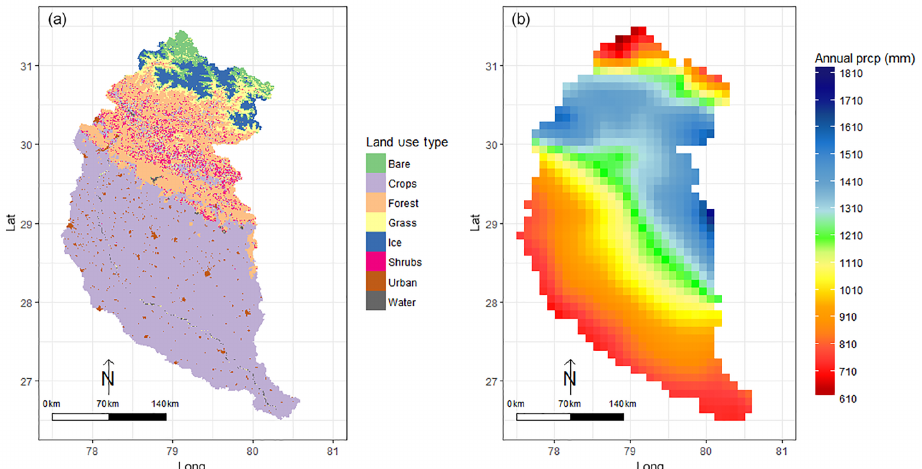
Figure 2. (a) Land-cover map of the Upper Ganges basin, for the year 2010, as developed by Tsarouchi et al. (2014). Landsat 7 ETM + images for October 2010 were acquired from the US Geological Survey Global Visualization Viewer. The images were co-registered to the UTM projection zone 44N, WGS 1984 datum, and corrected for radiometric and atmospheric effects. They were subsequently classified using a maximum likelihood classifier method with pixel training datasets, resulting in a land-cover map of eight different classes. For more information see Tsarouchi et al. (2014). (b) Annual average precipitation distribution in the study area, based on the TRMM 3B42v7A satellite product (years